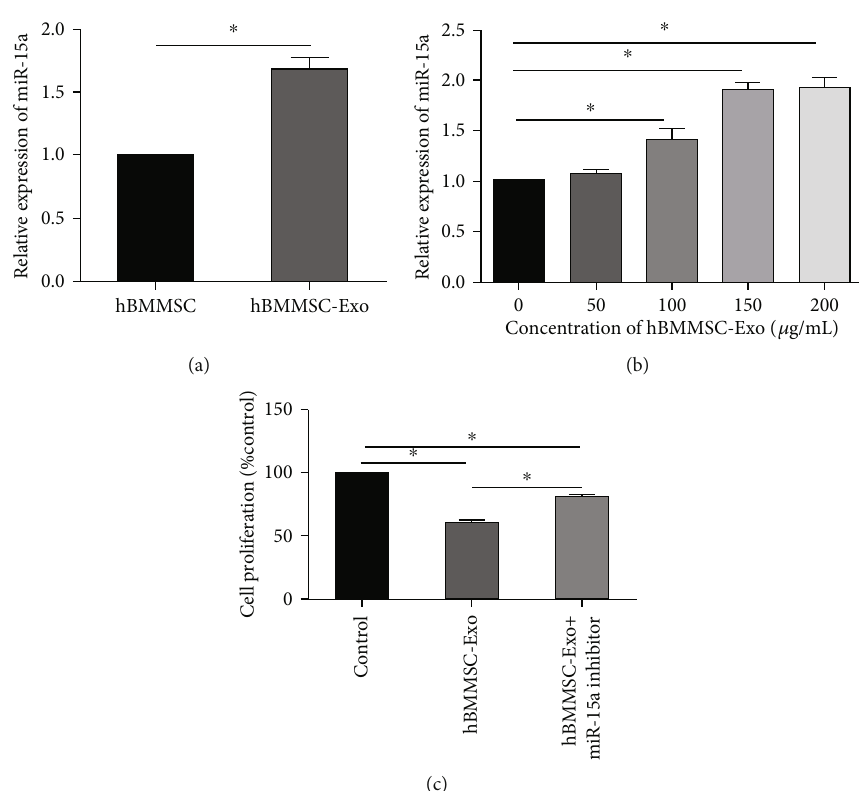
Figure 4: The transfer of miR-15a via hBMMSC-Exo. (a) The relative expression of miR-15a in hBMMSC and hBMMSC-Exo. (b) K562 cells were incubated with various concentrations of hBMMSC-Exo (0, 50, 100, 150, and 200 μ g/mL) for 48 h, and the miR-15a levels were evaluated. (c) K562 cells were transfected with miR-15a inhibitor (100nM) and incubated with hBMMSC-Exo (150 μ g/mL) for 48 h. Then, the proliferation of K562 cells was examined. The data were expressed as the mean ± SD of the three independent experiments. ∗ p < 0 : 05 Student ’ s t